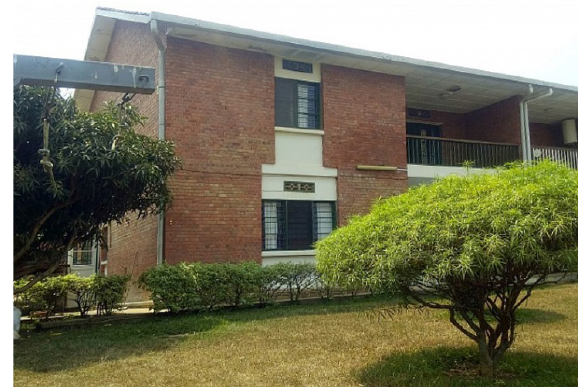
Figure 38. Twin House Type 3: Back yard. Photograph by Manlio Michieletto.